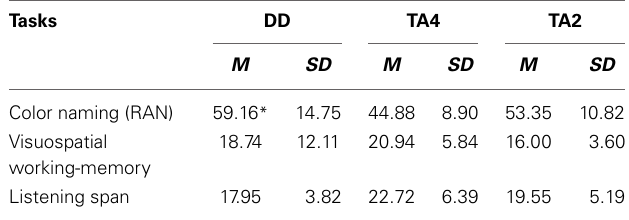
Table 2 | Overview of domain-general cognitive